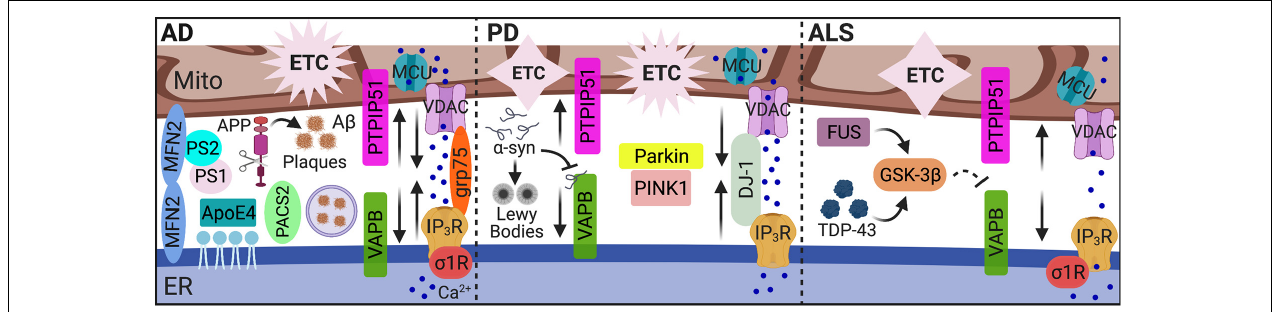
FIGURE 2 | MAMs in AD, PD, and ALS. While dysregulated MAM-associated mechanisms are hallmarks of neurodegenerative pathology, the unique pathological features of AD, PD, and ALS alter MAM contact and communication emphasizing MAMs as pivotal players in neuropathology. In AD, MAM contact, Ca 2 + transfer, and MAM-mediated mechanisms (i.e., autophagy) are increased among in vitro and mouse models, yet decreased MAM-mediator expression and interaction was found in human AD cortical tissues. In PD, both increased and decreased MAM contact and communication were reported. In ALS, MAM tethering and Ca 2 + transfer were significantly impaired. MAMs, mitochondria-associated ER membranes; Mito, mitochondria; ER, endoplasmic reticulum; AD, Alzheimer’s disease; A β , amyloid β ; APP, amyloid precursor protein; ApoE4, ε 4 allele of apolipoprotein E; PS, presenilin; MFN, mitofusin; PACS2, phosphofurin acidic cluster sorting 2; Ca 2 + , calcium; IP 3 R, inositol 1,4,5-triphosphate receptors; VDAC, voltage-dependent anion-selective channel; grp75, glucose-regulated protein 75 kDa; MCU, mitochondrial Ca 2 + uniporter; σ 1R, sigma-1 receptor; ETC, electron transport chain; PD, Parkinson’s disease; α -syn, α -synuclein; VAPB, vesicle-associated membrane protein-associated protein B; PTPIP51, protein tyrosine phosphatase-interacting protein 51; PINK1, phosphatase and tensin homolog-induced putative kinase; ALS, amyotrophic lateral sclerosis; TDP-43, transactive response (TAR) DNA-binding protein 43; GSK-3 β , glycogen synthase kinase-3 β ; and FUS, fused in sarcoma. Image created with